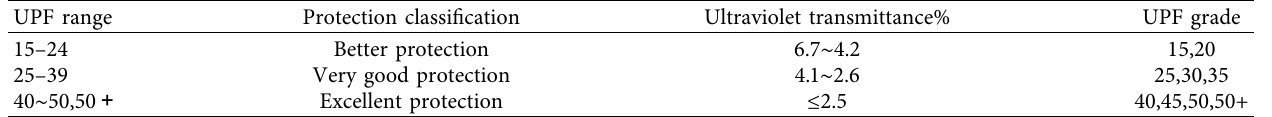
Table 1: UPF value and protection class.